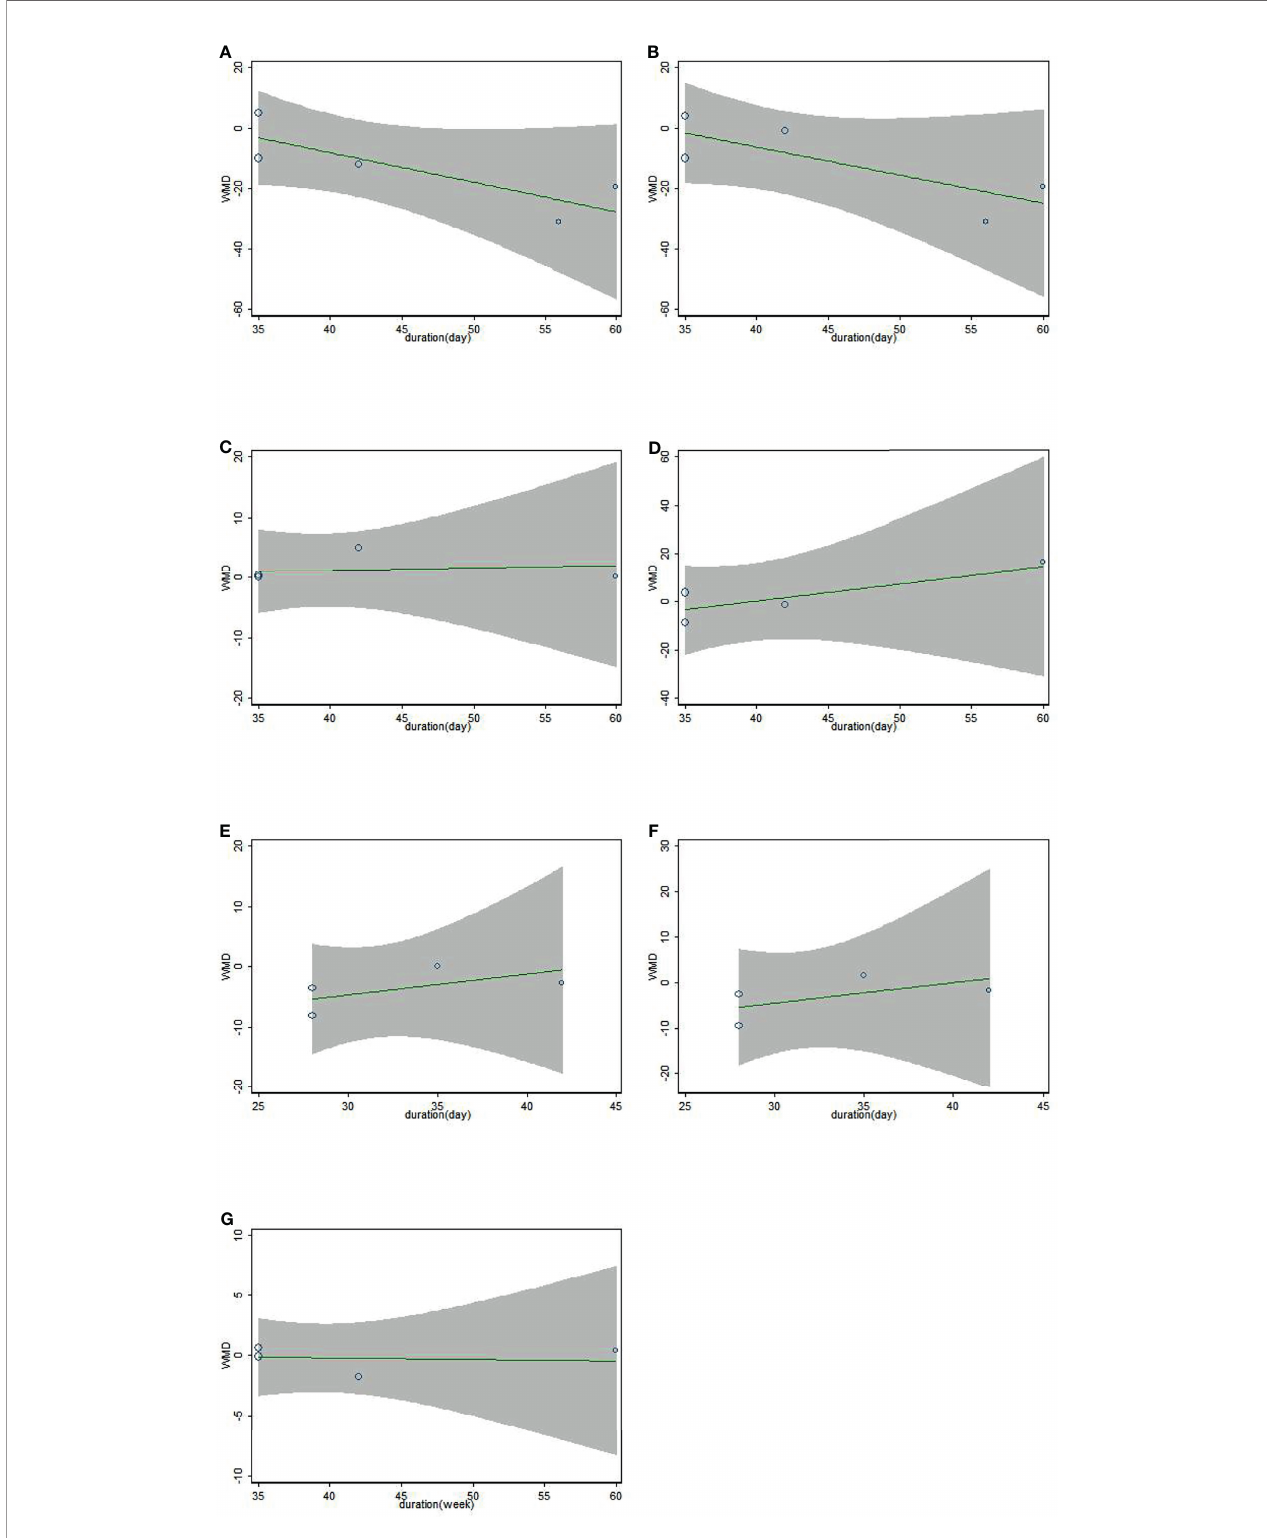
FIGURE 3 | Association between duration of study and effect size of sesamin supplementation on TC (A) , LDL-c (B) , HDL-c (C) , TG (D) , SBP (E) , DBP (F) , and weight (G)